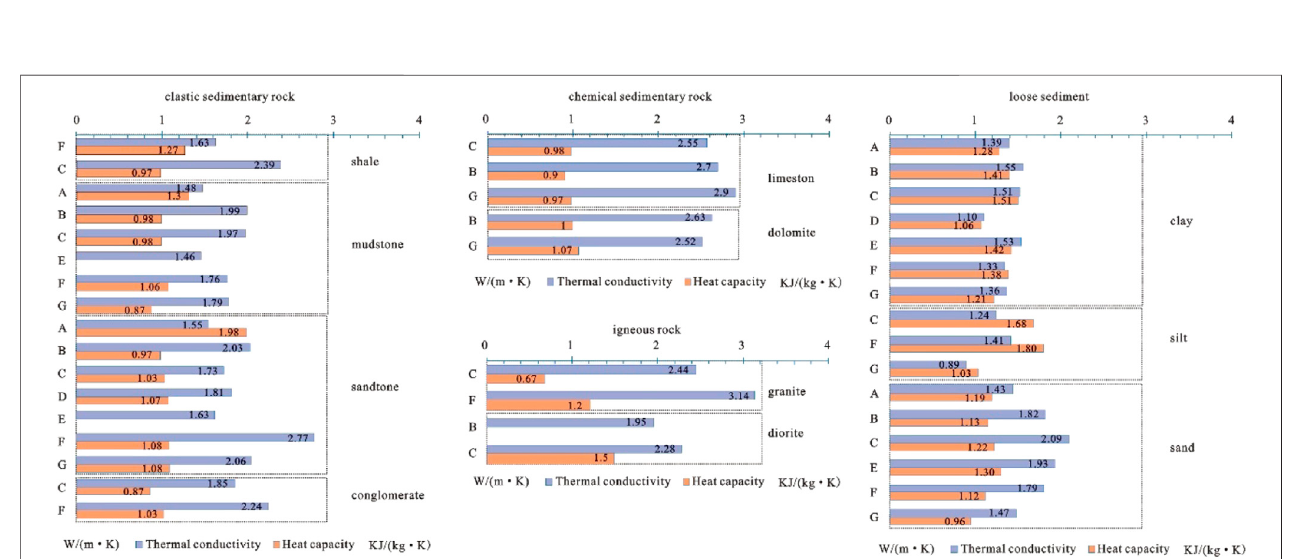
FIGURE 5 | Relationship between the thermal and physical parameters of each lithology in different regions.